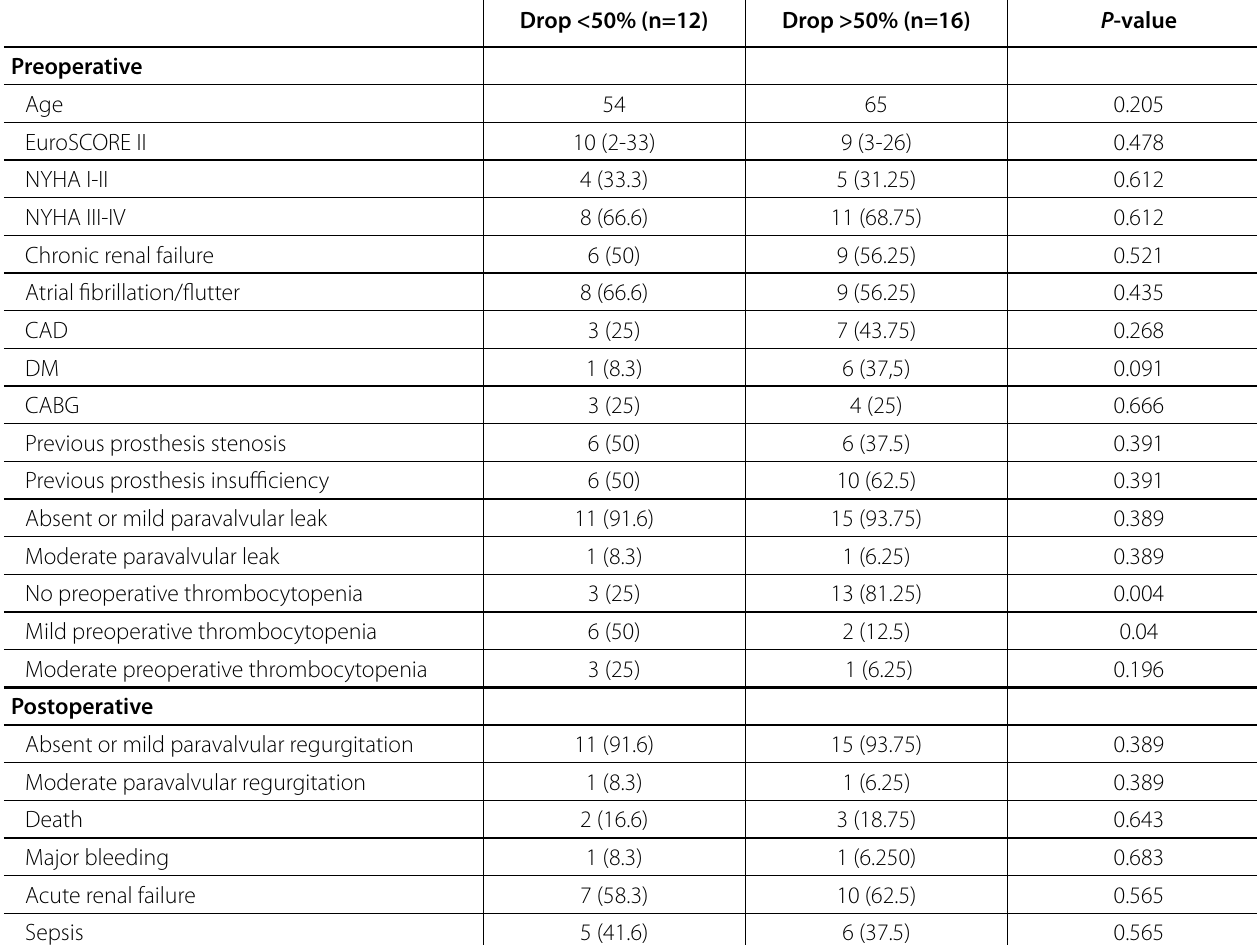
Table 4 . Baseline and postoperative characteristics of valve-in-valve patients according to the degree of thrombocytopenia in relation to each individual’s baseline platelet value and proportional drop in platelet